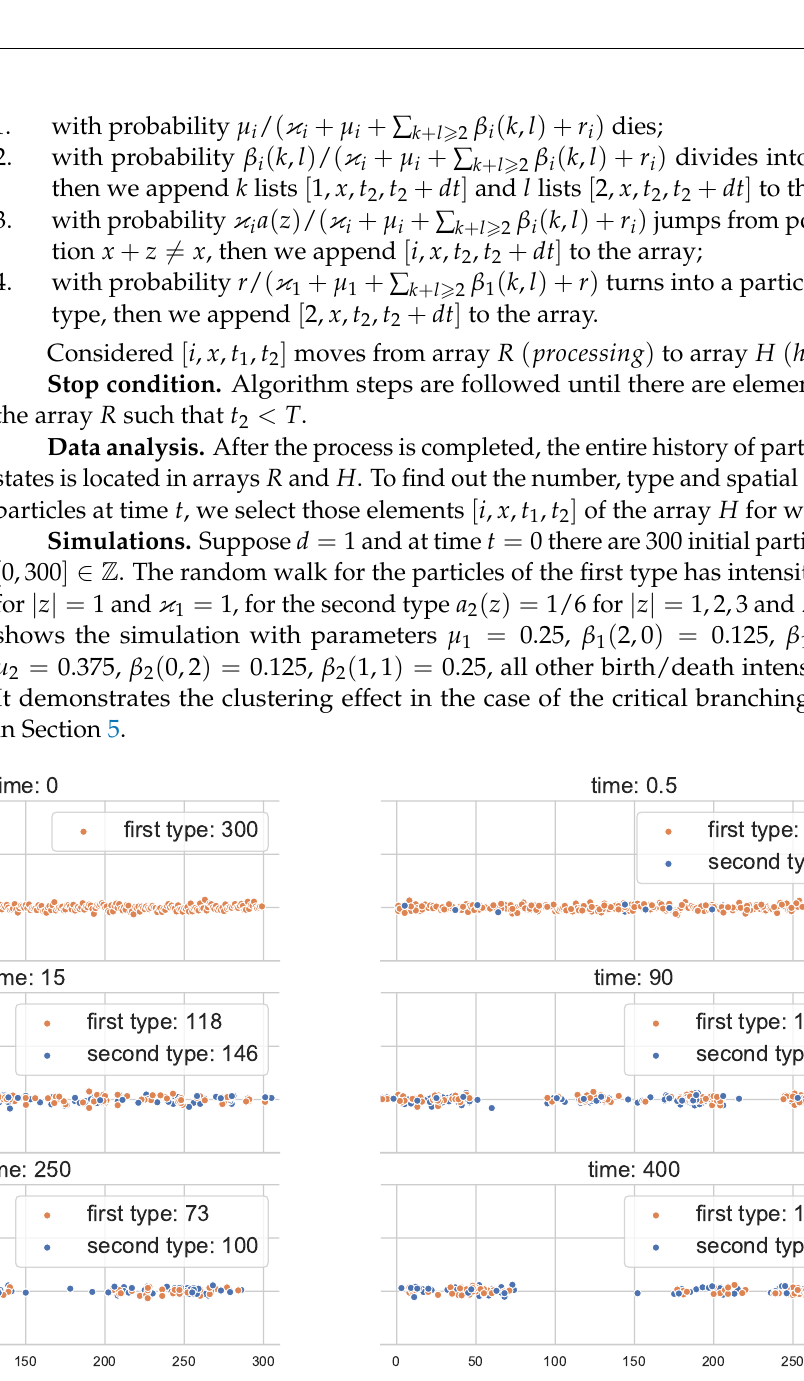
Figure 1. Particle populations on Z 1